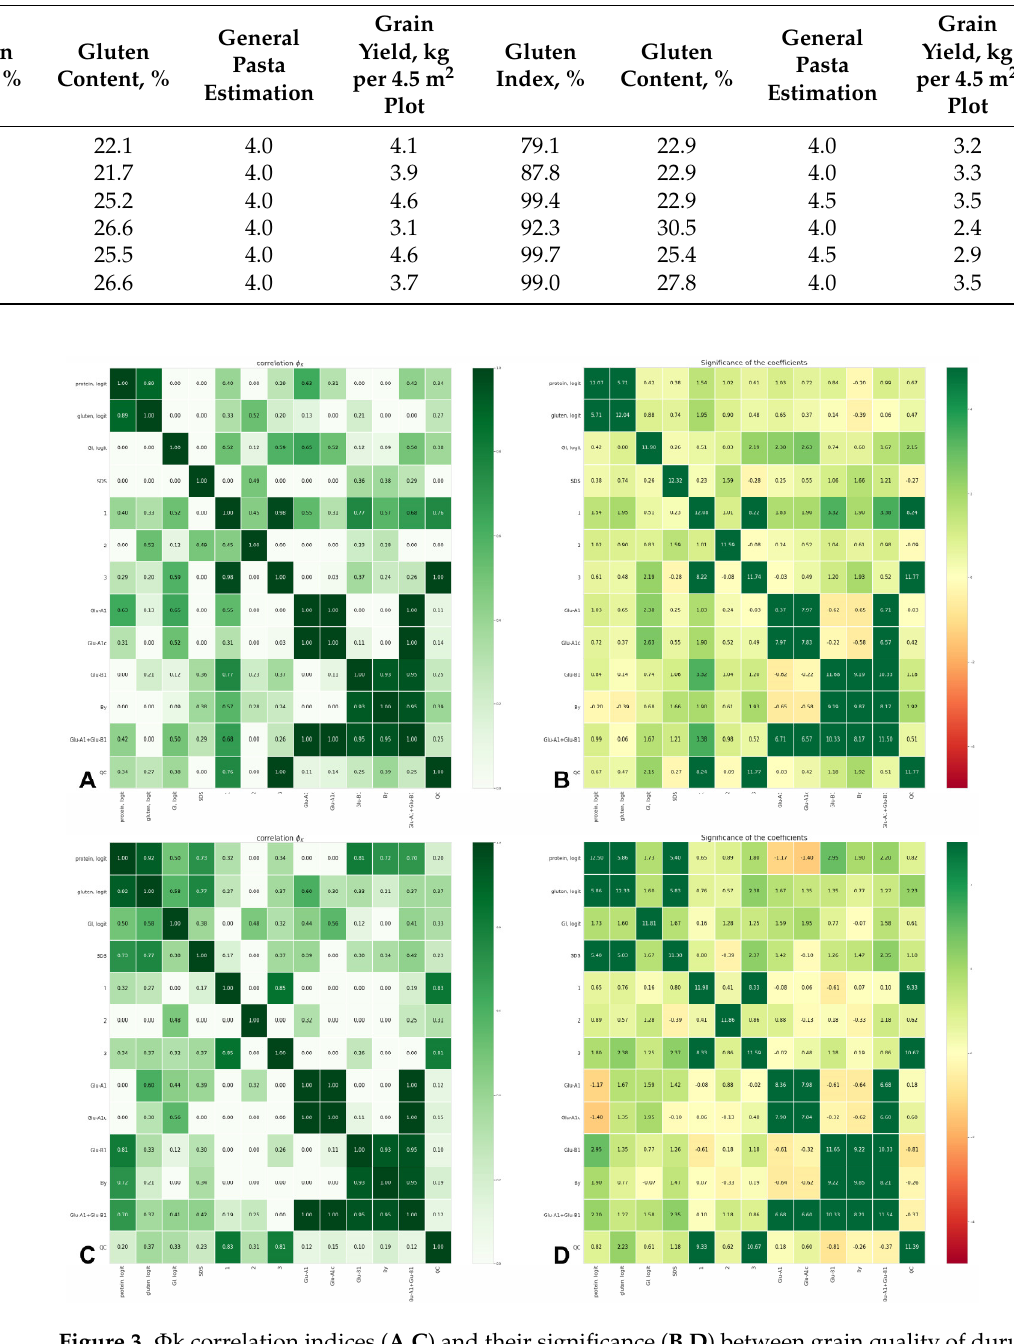
Figure 3. Φk correlation indices ( A , C ) and their significance ( B , D ) between grain quality of durum